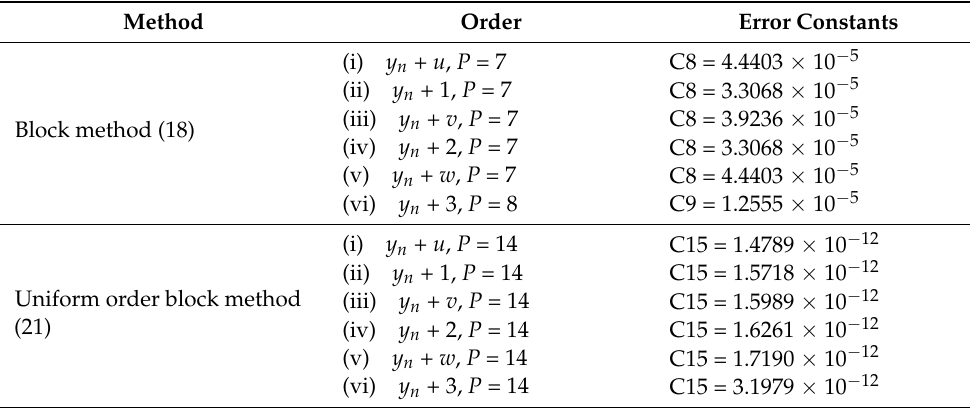
Table 1. Order and error constants for the block hybrid